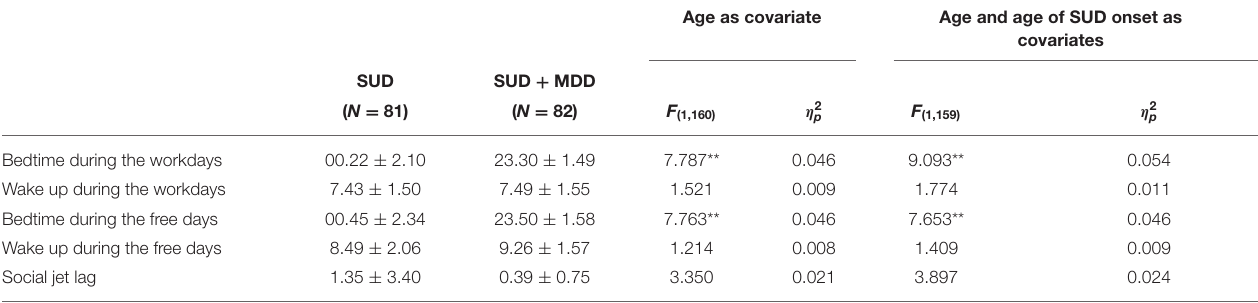
TABLE 3 | Social jet lag (SJL) and related parameters for the SUD and SUD + MDD.